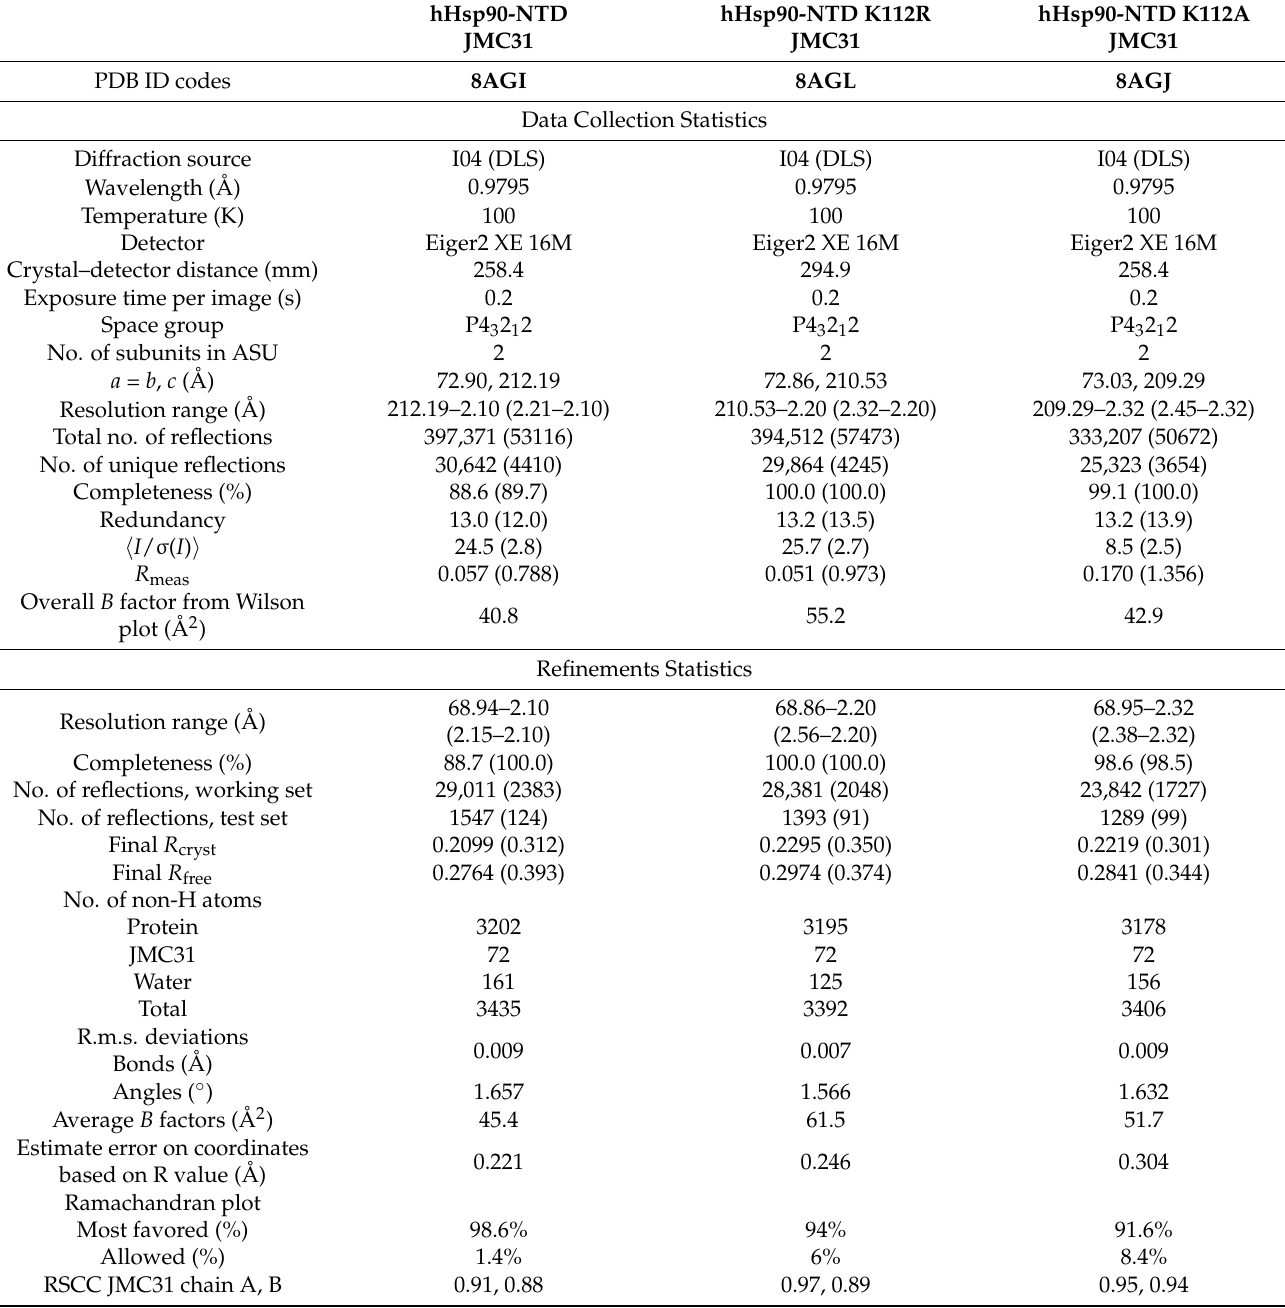
Table 1. Data collection and refinement statistics. Values for the outer shell are given in